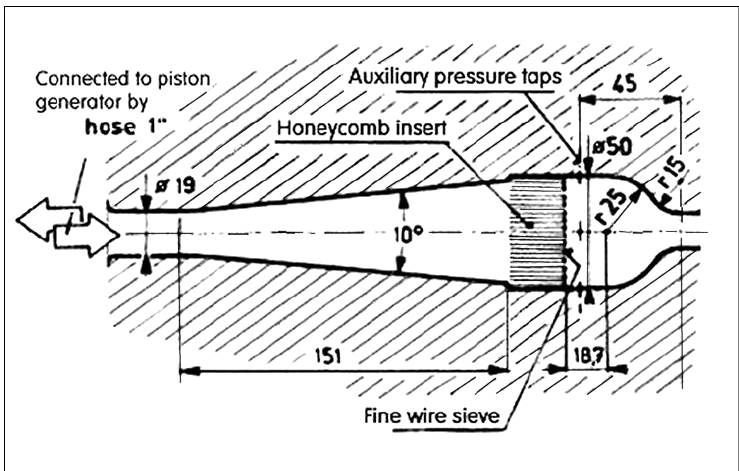
Figure 5. Geometry of the inlet into the primary nozzle. Initial considerations of precise flow measurements in the mixing tube called for a very regular supply flow, stabilised by honeycomb, sieve, and area contraction seen in this illustrations.